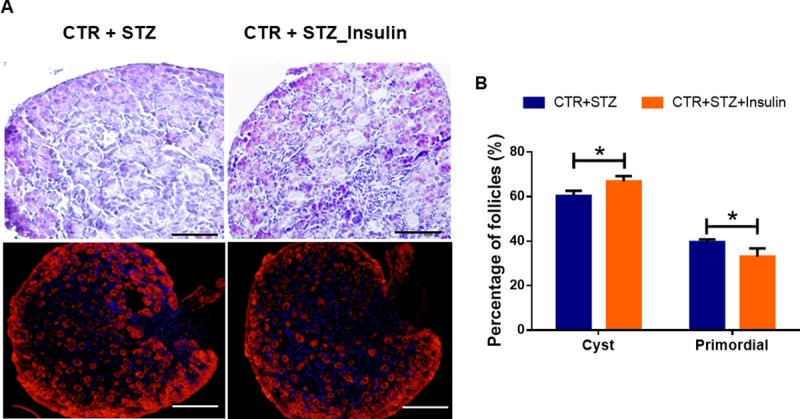
Insulin restores abnormal follicle development in newborn mice caused by STZ-induced gestational diabetes.(A) The histological appearance (Scale bars: 50 μm) and ovary whole-mount substratesimmunofluorescence of the newborn mouse ovarian tissue(Scale bars: 100 μm) in control and STZ-Insulin-treated groups. (B) It showed the percentage of oocytes in cyst and primordial follicle in STZ-treated and STZ-Insulin-treated groups at PND 1. At least 5 mice were analyzed in each group; Date are presented as mean ± SEM. *shows a significant difference between STZ-treated and control at P < 0.05; ** shows a significant difference at P < 0.01.